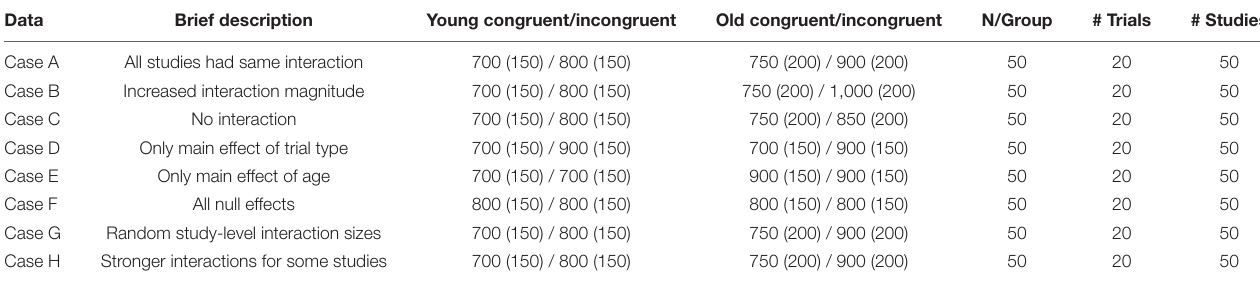
TABLE 1 | Simulated data